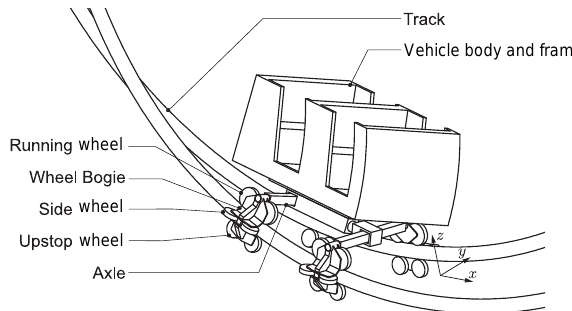
Figure 1. Roller coaster vehicle.